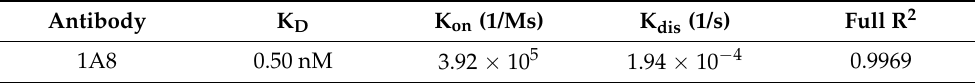
Table 1. Affinity determination by Bio-Layer Interferometry with Octet